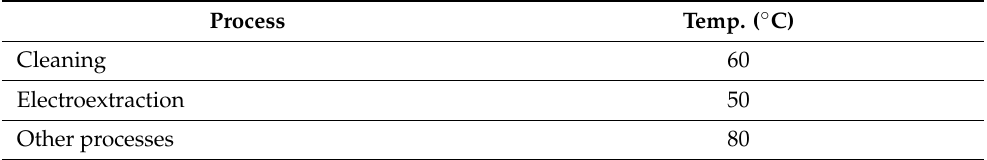
Table 9. Mining industry process